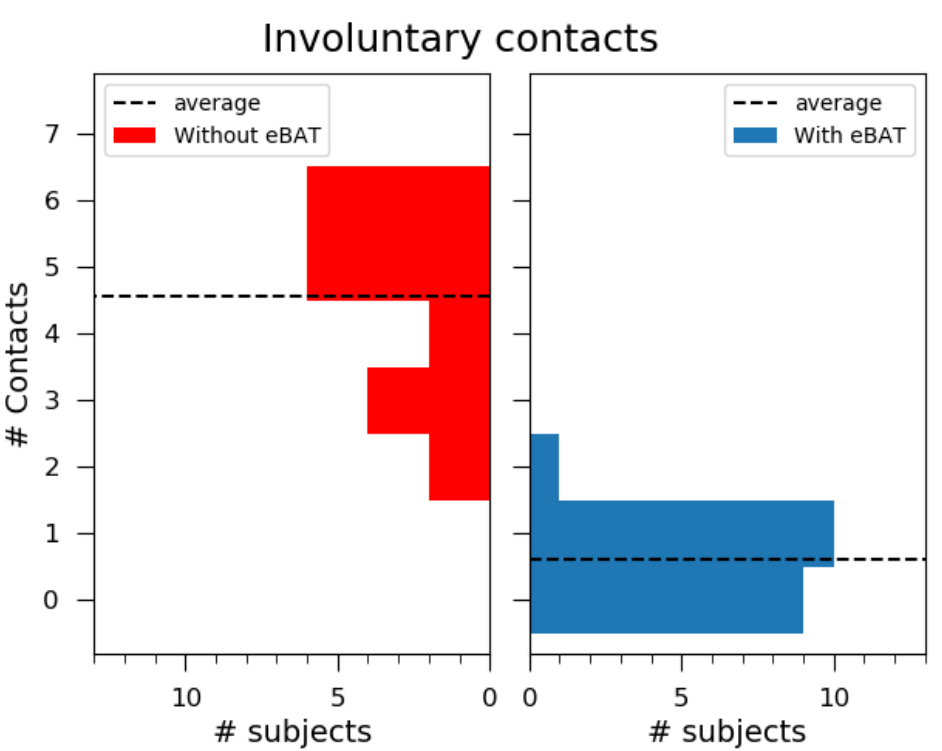
Figure 18. Histograms of number of involuntary contacts without ( left panel ) and with ( right panel ) the usage of the eBAT. Dashed lines indicate the average for each condition. It can be observed that the distribution without the eBAT is much lower, with the maximum at one involuntary contact.